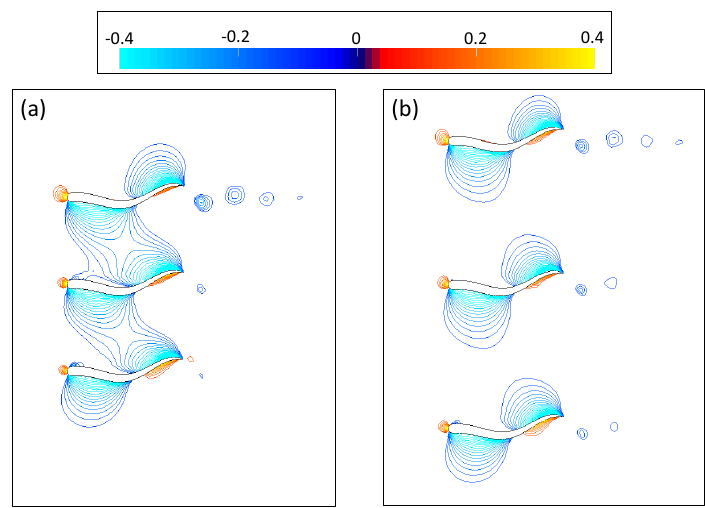
Figure 14. The contours in pressure field of the phalanx swarm: ( a ) spacing = 0.75 L , ( b ) spacing = 1.25 L